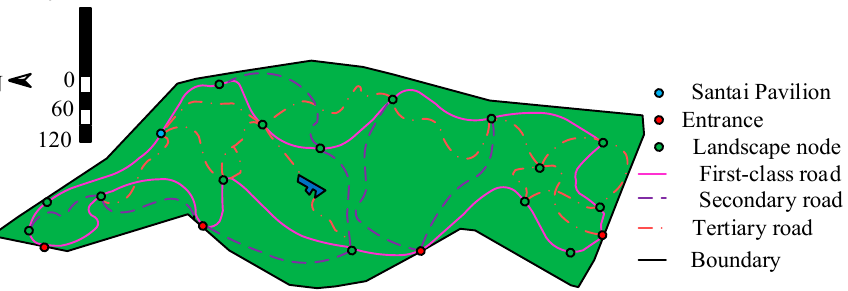
Figure 3. Schematic diagram of the parametric network design of Lanshan Mountain Ecological Park.